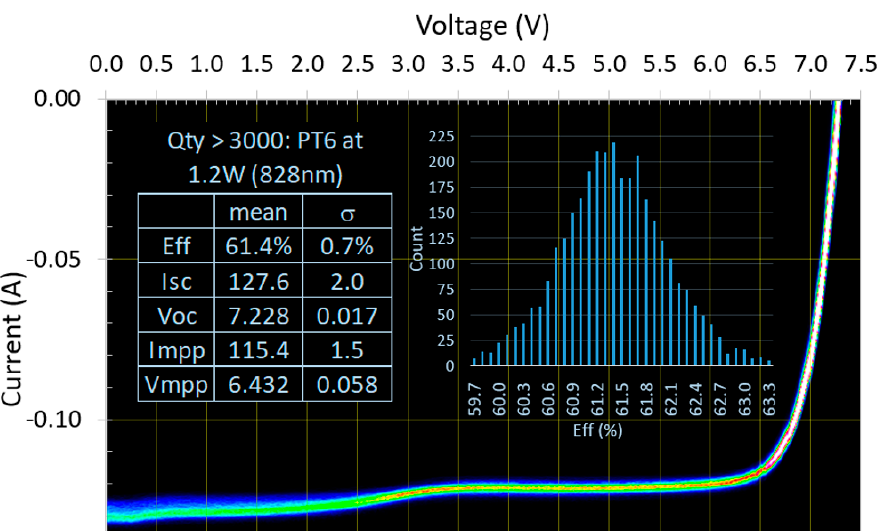
Figure 1. Performance of regular ‐ power PT6 from a group of over 3000 devices (Broadcom’s AFBR ‐ POC206A1). Measured at room temperature (T ~ 23 °C) with an input power of 1.2 W at 828 nm. The chip area is 0.03 cm 2 , giving an average optical input intensity of 37 W/cm 2 at 1.2 W. Histogram and statistics are shown in the insets. The density plot of all the current ‐ voltage (I ‐ V) curves is traced using a rainbow color scheme (cold colors correspond to lower occurrence points and hot colors correspond to higher occurrence points).